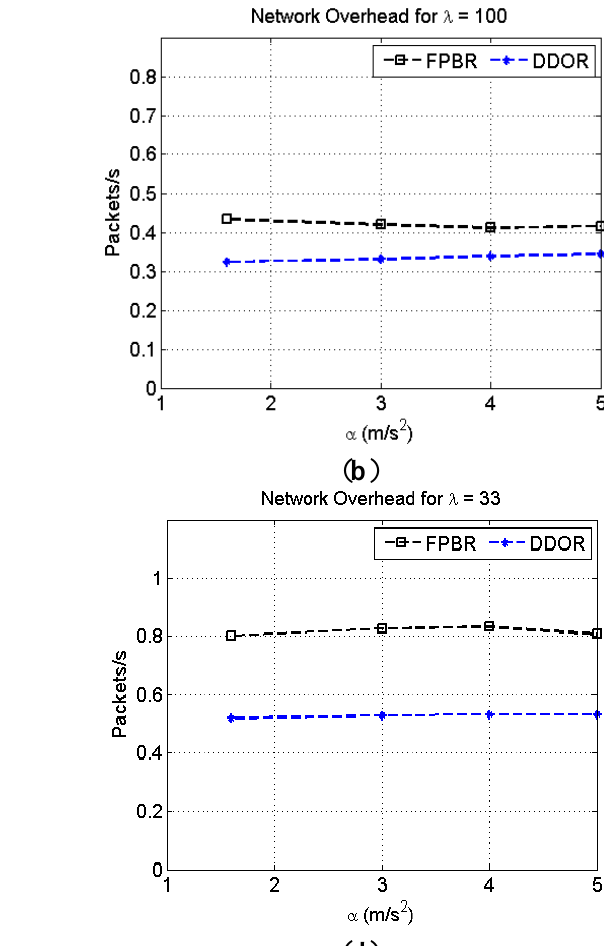
Figure 15. Normalized network overhead obtained with FPBR and DDOR when increasing the maximum acceleration, . Four different vehicle densities, , were considered for these plots. Each plot shows the network overhead vs. α for: ( a ) λ = 133; ( b ) λ = 100; ( c ) λ = 66 and ( d ) λ =